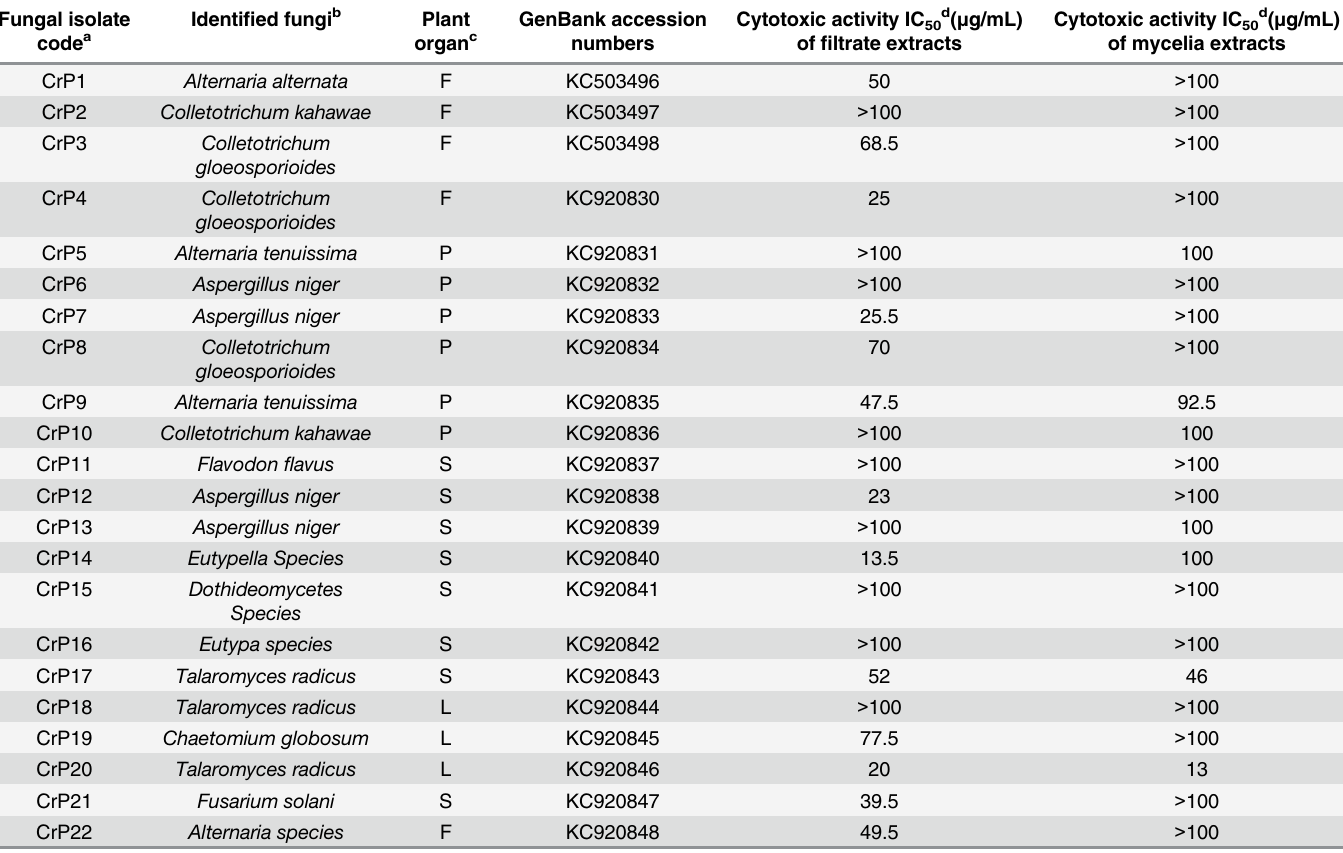
Table 2. Details of the endophytic fungi isolated from C . roseus and the antiproliferative effects (IC 50 values) of their crude extracts against human HeLa cells. Fungal isolate code a